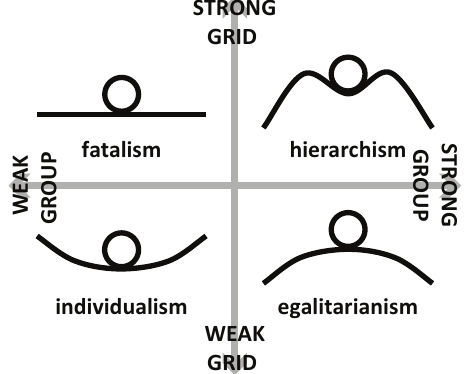
Figure 1. The rationalities of Cultural Theory (“grid and group”